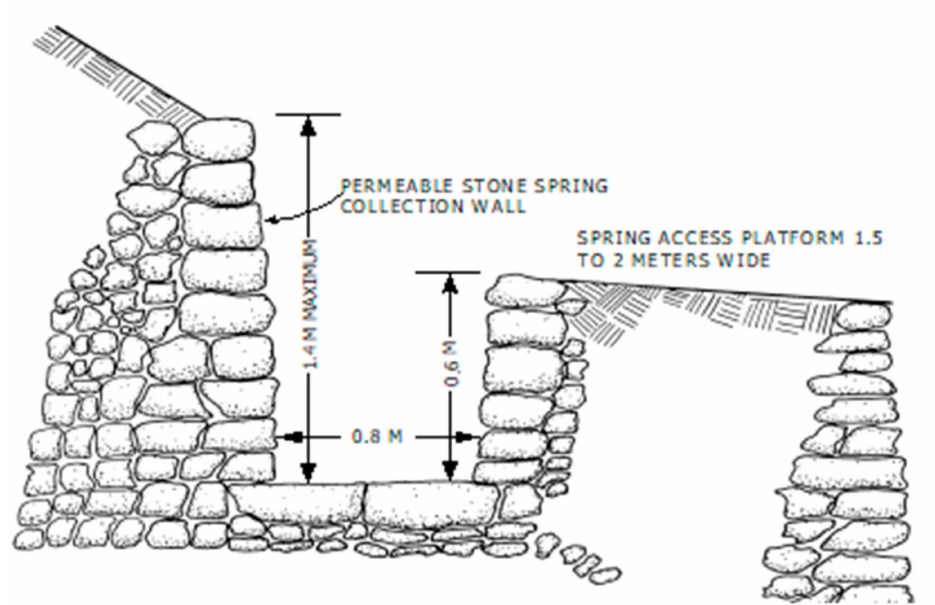
Figure 4. Cross-section of the Inca Spring collection system, which enhanced the domestic water supply for Machu Picchu. The yield of the spring was maximized by a permeable stone wall set into the steep hillside and a collection trench, which in turn fed the canal shown below (Reproduced from Machu Picchu: A Civil Engineering Marvel [5], with permission from ASCE, the publisher.)